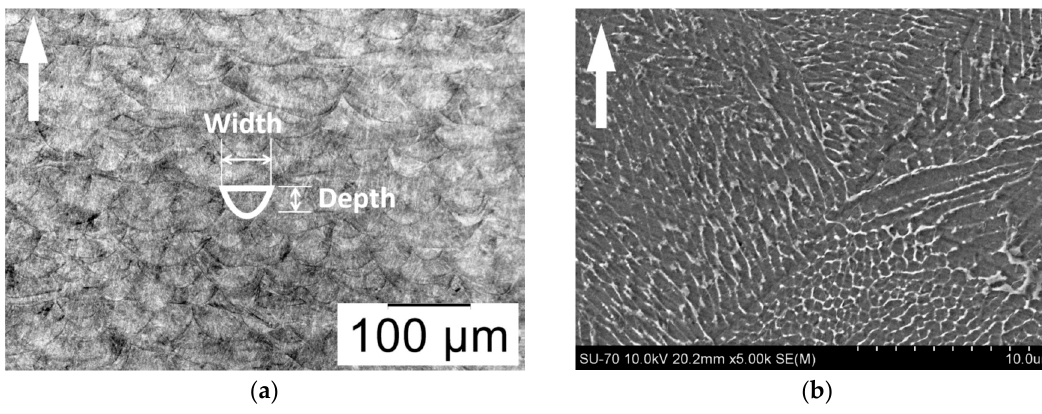
Figure 4. ( a ) Low magnification optical and ( b ) high magnification Scanning Electron Microscope (SEM) images of laterally sectioned structure fabricated with the EOS EOSINT M280 L-PBF system using the manufacturer’s recommended set of parameters (MS1 Performance 2.0) and EOS maraging steel 300 powder (codified by EOS as MS1). The arrows indicate the additive manufacturing (AM) build direction.